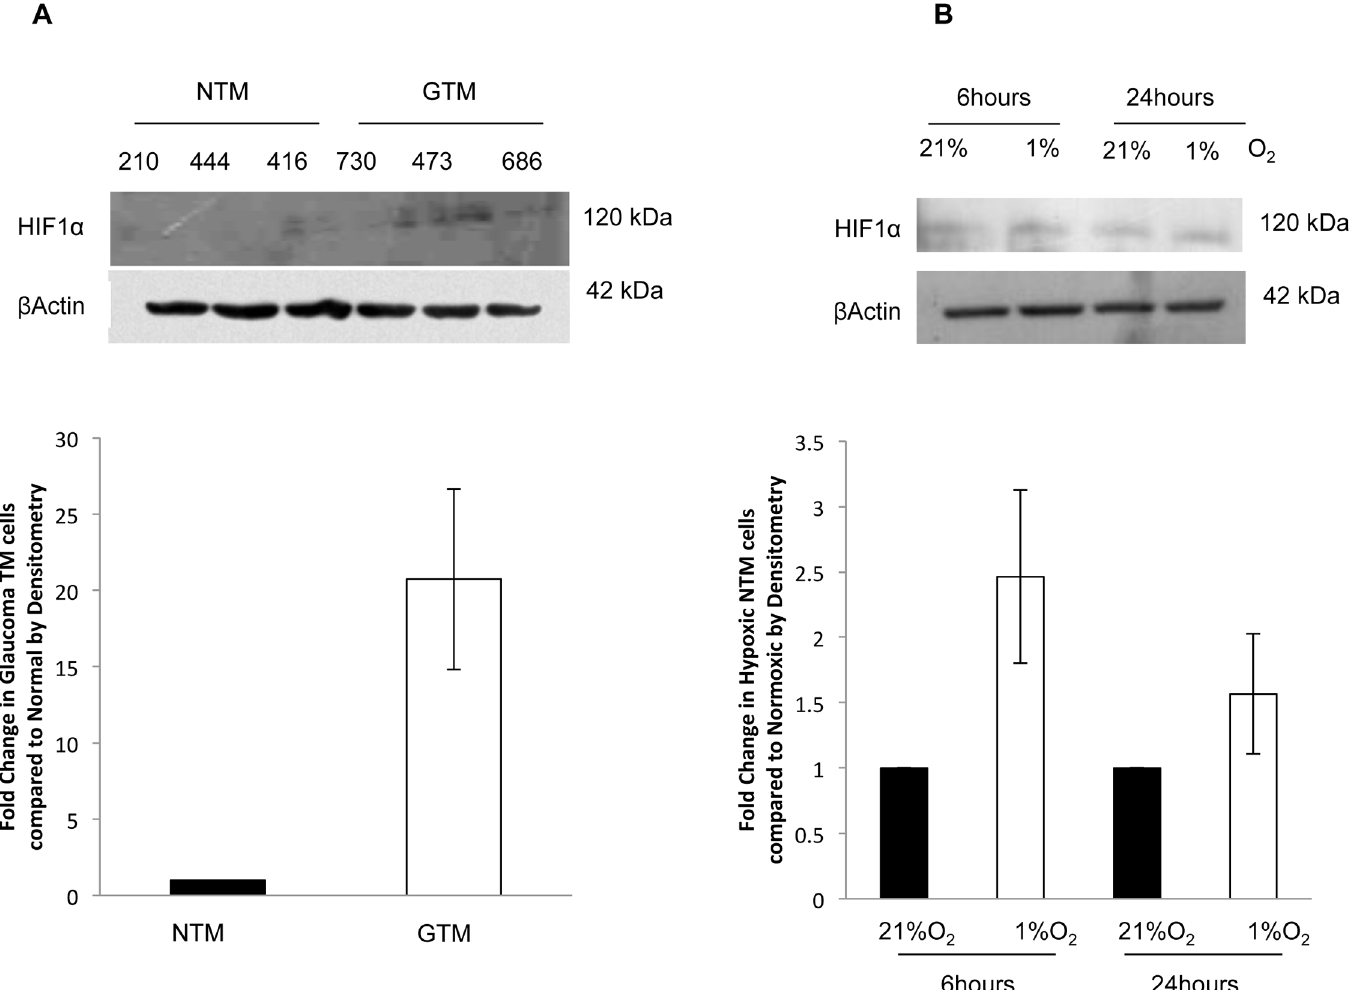
Fig 4. HIF1 α protein expression by Western blotting was increased in GTM cells and in NTM cells subjected to hypoxia. Expression of HIF1 α in glaucomatous TM cells compared to NTM cells, and in NTM cells subjected to 1%O 2 by Western blotting. A. HIF1 α expression was increased in GTM cells compared to NTM cells, this was reflected in densitometry conducted on the blots. 3 normal and 3 glaucoma donors used (donor cell strains indicated) B. A hypoxic environment (1%O 2 ) was able to induce HIF1 α expression in NTM cells at both 6 hours and 24 hours. This was also seen in the densitometry conducted on the blots. Results show data from 3 independent